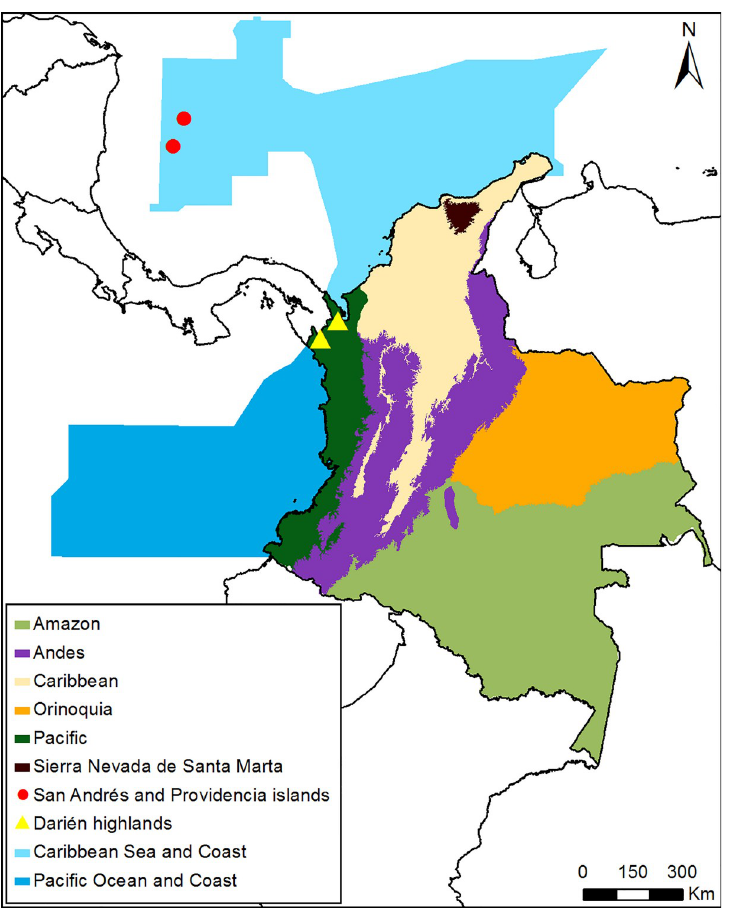
Fig 1. Regions of Colombia used for disaggregated RLIs. San Andre´s and Providencia Islands and Darie´n Highlands are represented with symbols because they are too small to be seen at the scale of the map.